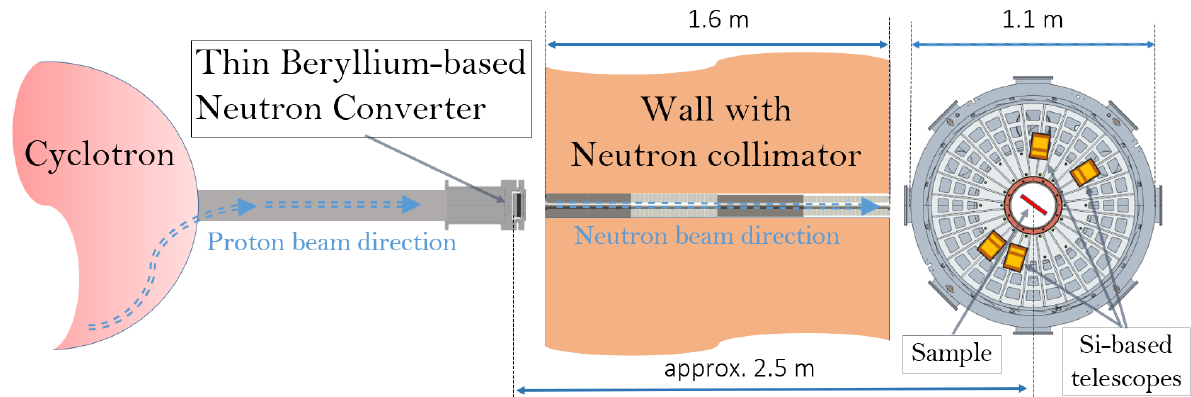
Figure 1. The top-view schematics of the experimental set-up used with the reaction chamber.